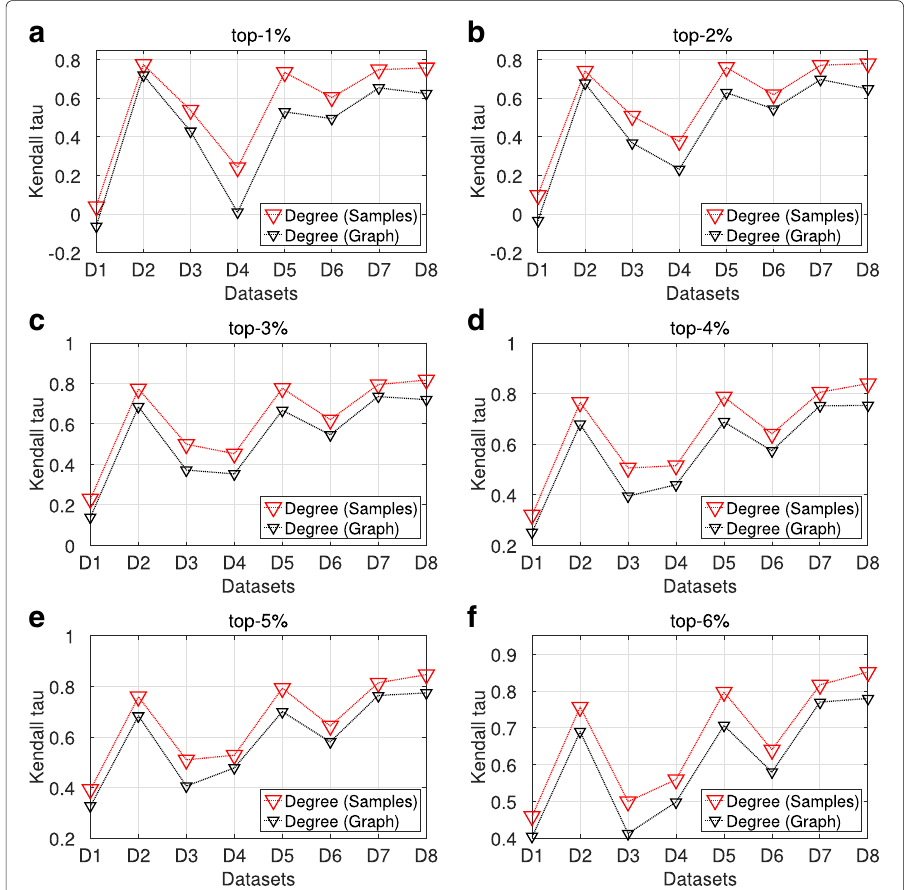
Fig. 5 Ranking similarity, SIR epidemic. a - f Average Kendall tau values in terms of degree centrality obtained from maxRD samples, along with the Kendall tau values based on degree centrality obtained from the original